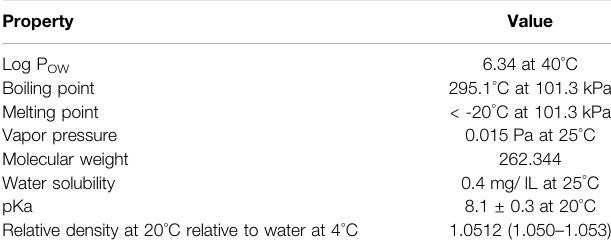
TABLE 1 | Physicochemical properties of homosalate [taken from the REACH dossier (ECHA 2020)]. Property